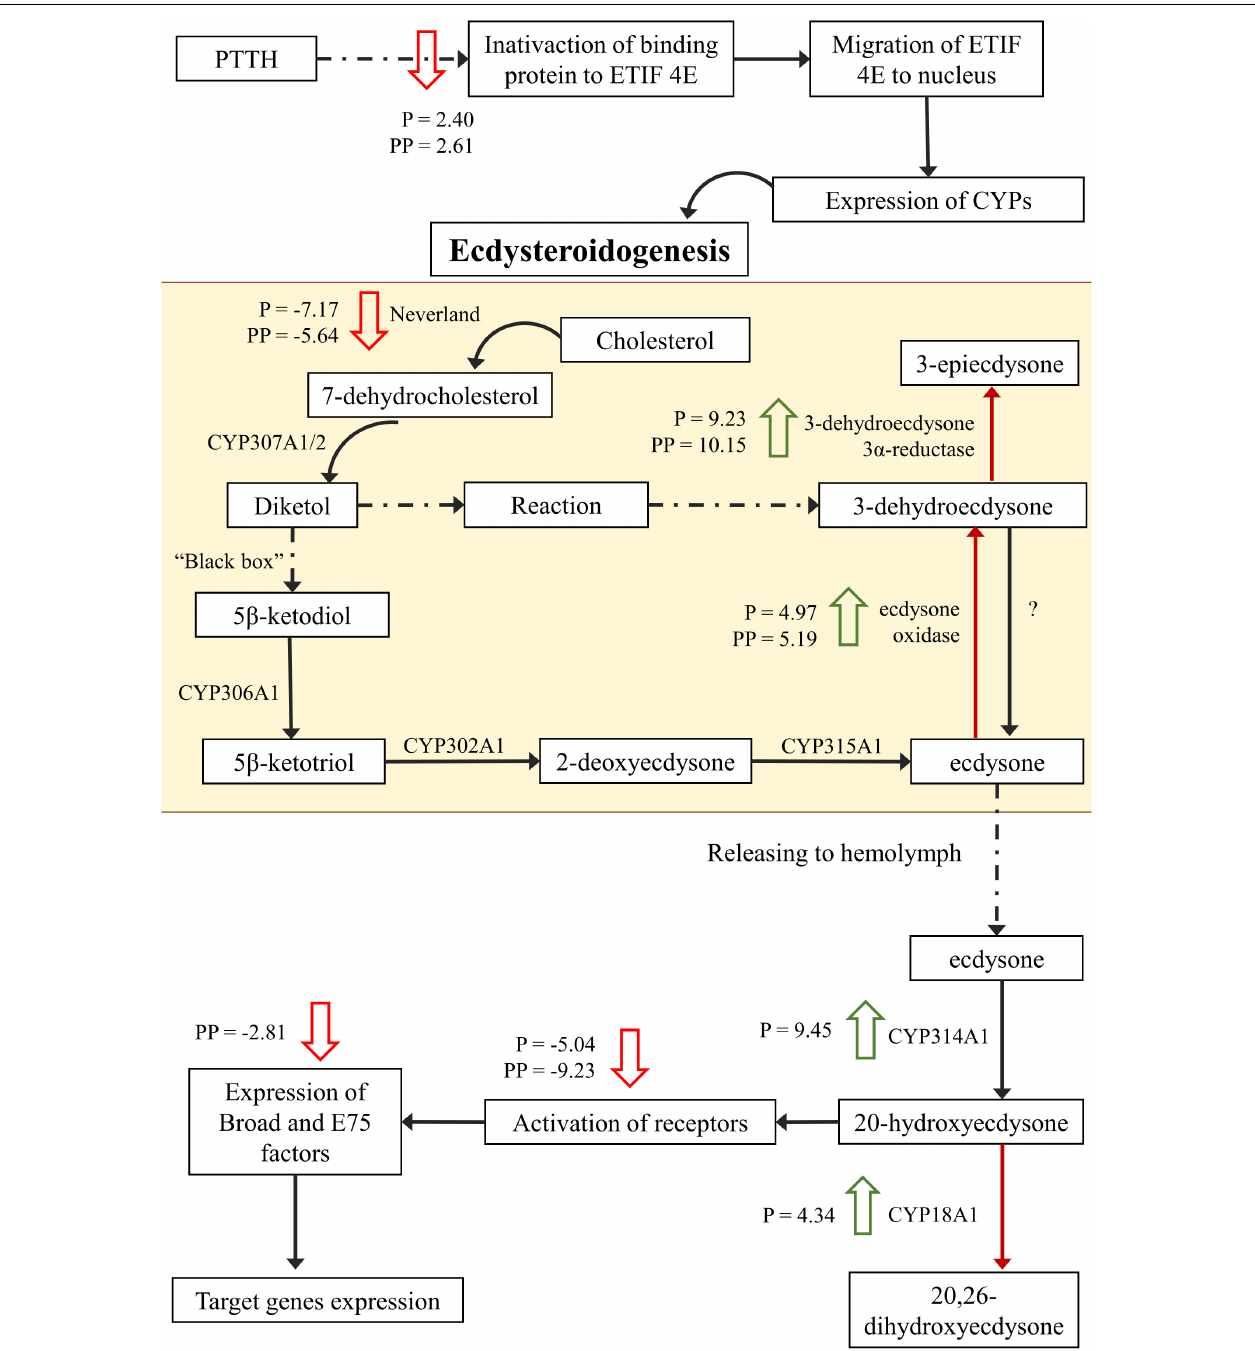
FIGURE 6 | Simplified pathways for ecdysteroid synthesis and release in prothoracic glands. Dashed arrows indicate different reactions and red arrows indicate ecdysteroid inactivation. Large green arrows indicate superexpression of enzymes in Diatraea saccharalis parasitized (P) and/or pseudoparasitized (PP) by Cotesia flavipes . Large red arrows indicate inhibition of expression in parasitized and/or pseudoparasitized larvae. CYP, cytochrome P450 enzymes; ETIF, eukaryotic translation initiation factor; PPTH, prothoracicotropic